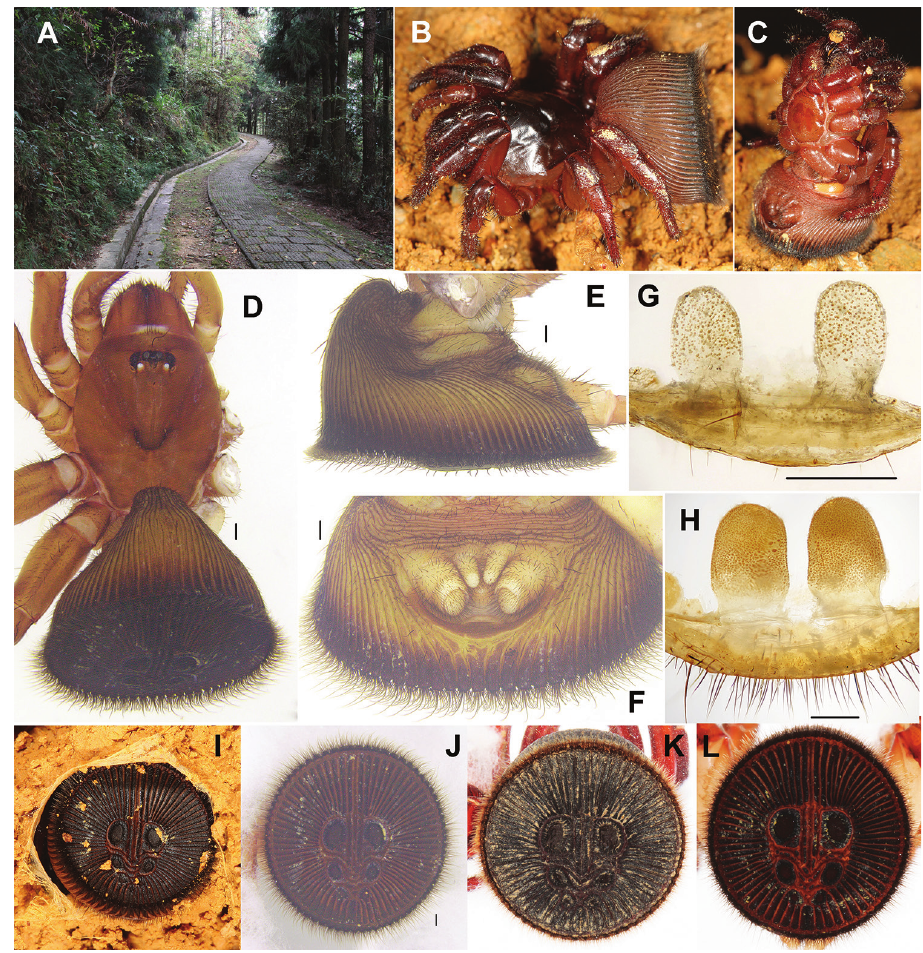
Figure 1. Cyclocosmia ricketti (Pocock, 1901) A habitat B–D habitus of female (XUC-2013-013) E abdomen, lateral view F posterior portion of opisthosoma, ventral view, showing spinnerets G fe- male genitalia (XUC-2013-013), dorsal view H female genitalia (tianzishan-2016), dorsal view I showing opisthosomal disc in plugging position (XUC-2013-013) J–L abdomen, caudal view ( J XUC-2013-013 K Tianzishan-2016 L C-2016-001). Scale bars 0.5 mm. tooth. Palp with a single claw bearing one tooth. Measurements: palp 10.06 (4.00 + 2.10 + 2.30 + 2.20), leg I 11.00 (4.20 + 1.60 + 2.50 + 1.50 + 1.20), leg II 8.60 (3.20 + 1.40 + 1.50 + 1.40 + 1.10), leg III 8.50 (3.50 + 1.30 + 1.20 + 1.00 + 1.50), leg IV 12.20 (4.00 + 2.60 + 2.10 + 2.00 + 1.50). Formula: 4123. Abdomen funnel-shaped and dark yellow-brown (Fig. 1D). Caudal disc slightly concave, 8.80 in transversal diameter and 8.50 in longitudinal diameter, with two rids running dorso-ventrally and 32/33 (XUC-2013-013), 29/28 (Tianzishan-2016), 33/33 (C-2016-001) radiating ribs on each side. Abdominal disc with six